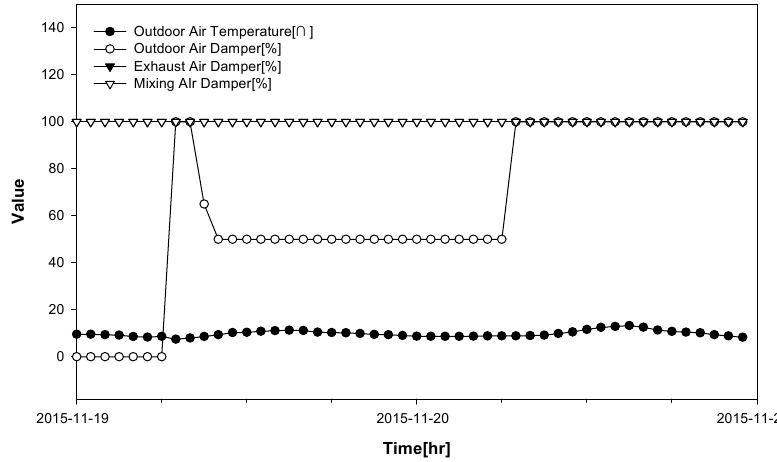
Figure 3. Rate of damper opening per hour of the target building.